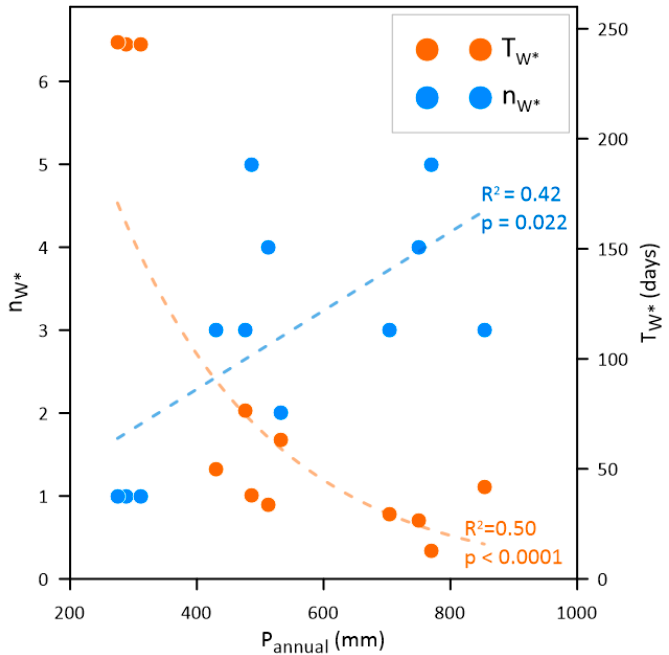
Figure 5. Relation of number ( n W* ) and mean duration ( T W* ) of drought stress events with annual precipitation ( P anual ).